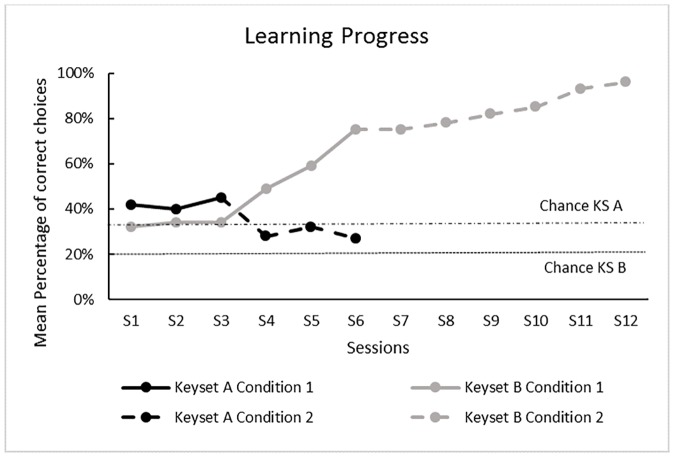
Selection: Percentage of correct choices per trial over sessions.Black line = keyset A; grey line = keyset B; intact grey/black line = condition 1; dashed grey/black line = keyset B; Chance expectation for keyset A = 33% correct; for keyset B = 20% correct.